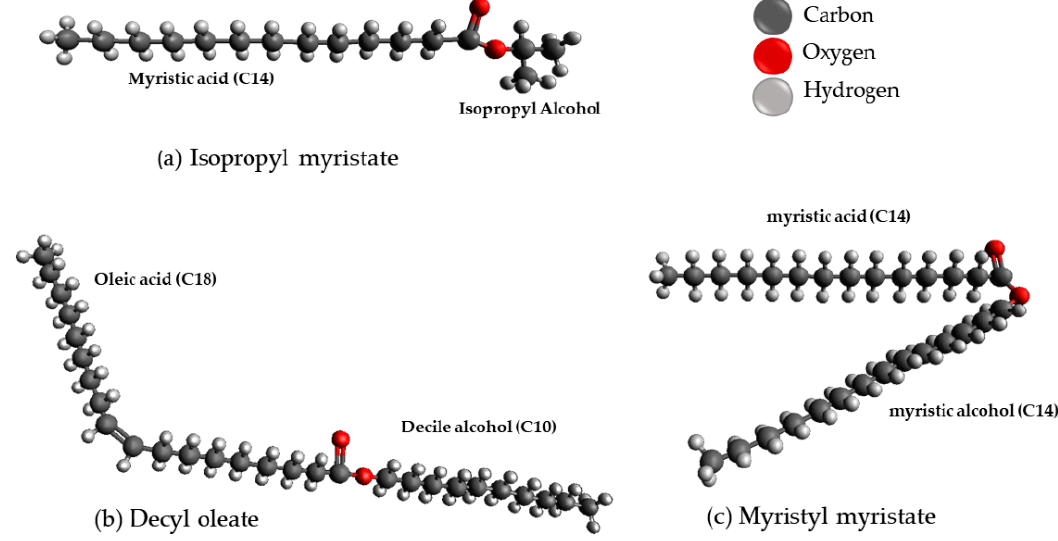
Figure 3. Chemical structure of emollients commonly used in cosmetic formulations, ( a ) Isopropyl myristate; ( b ) Decyl oleate and ( c ) Myristyl myristate.